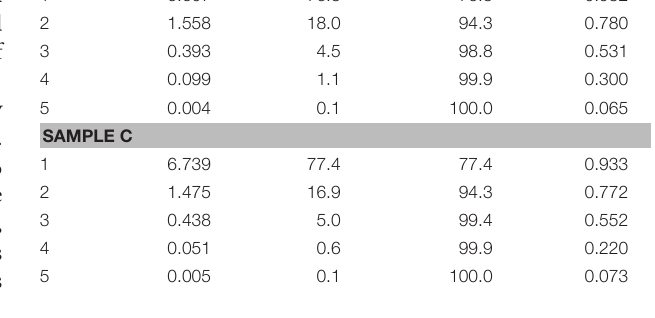
TABLE 4 | Descriptive statistics of the 6-cluster solution in Sample A ( n = 2,364). Iceberg profile ( n = 695) Inverse Everest profile ( n = 64) Inverse iceberg profile ( n =